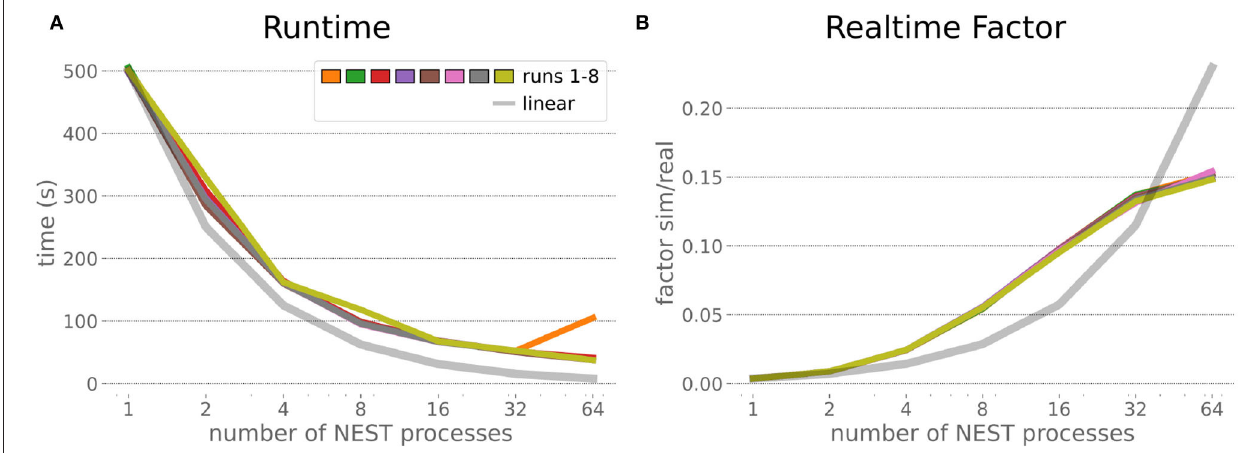
FIGURE 7 | HPC Benchmark runtime and real-time factor. The runtime (A) can be reduced by a factor larger than 12 from 500s to about less than 40s by exploiting 64 NEST processes on 32 compute nodes compared to a single process. Simultaneously, the real-time factor (B) improves supra-linearly, but performance increases less significantly when using more than 32 NEST